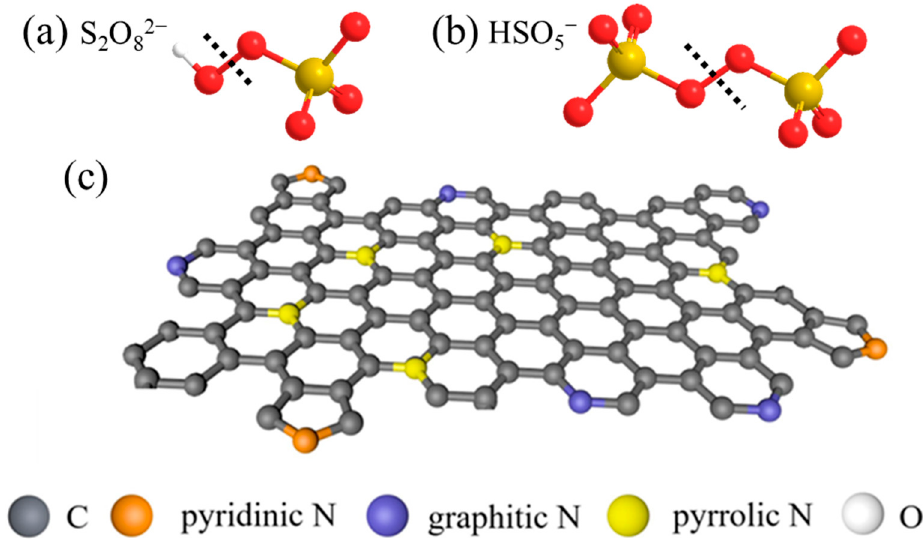
Figure 1. The structure of ( a ) PDS and ( b ) PMS, and ( c ) the structure of different N species [39], copyright 2021, Elsevier.